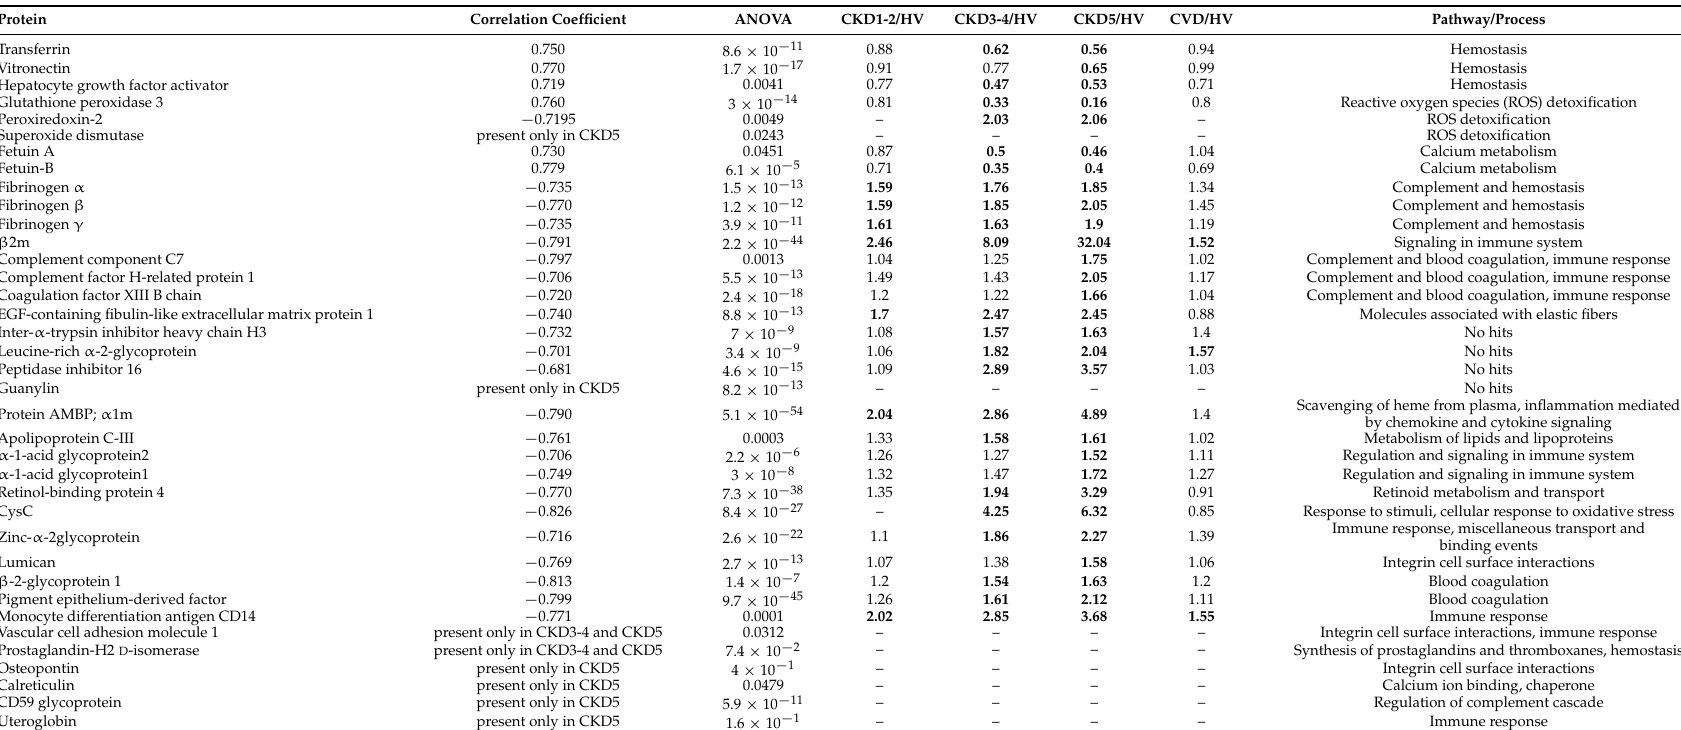
Table 3. A list of 29 proteins associated with CKD progression and consequently with the eGFR level. Eight proteins were specific only for advanced stages of CKD. The correlation coefficients were determined using the estimated glomerular filtration rate (eGFR) of the plasma samples and the LFQ intensities of proteins. The molecular functions/pathways for all proteins were defined using DAVID tools and GO annotations. The fold changes were calculated against the HV group, and the fold changes were only calculated against CKD1-2 for the two proteins (peroxiredoxin-2 and cysC). The differences identified as significant (with fold change >1.5 or <0.66 and p < 0.05) are in